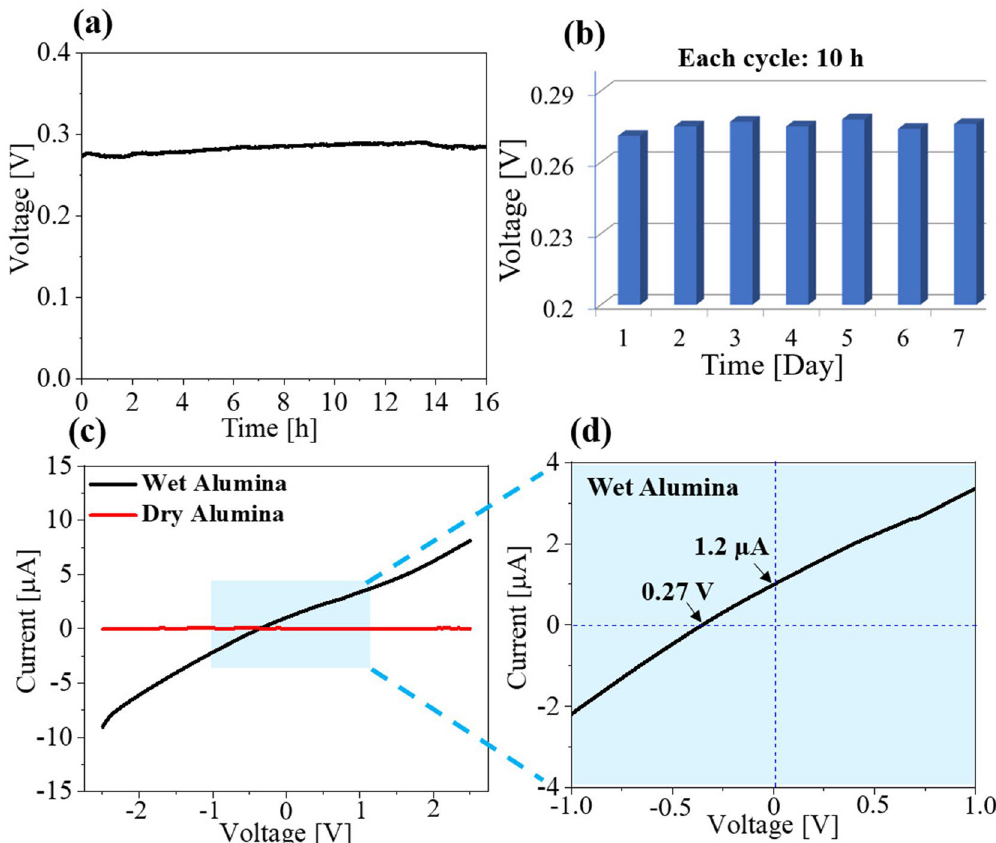
Figure 2. ( a ) Voltage generated by alumina with respect to time when the alumina block was immersed 1.5 cm in water. ( b ) Voltage generated by alumina continuously for 7 days, in which each cycle represents 10 h of measurements per day. ( c ) An I-V curve with the dry sample without water and wet sample half-immersed in water. ( d ) Magnified I-V curve near the origin shown in ( c